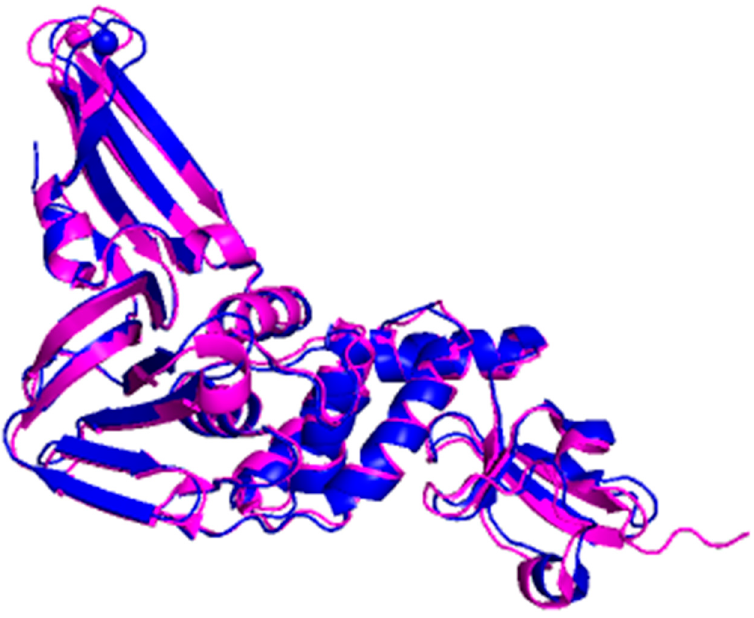
Figure 7. The superimpose of PLpro between SARS-CoV-2 (blue colour, PDB ID: 7D7K) and SARS- CoV (magenta colour; PDB ID: 2FE8) structures with R.M.S.D value of 0.792 Å. It was visualized with PyMOL.